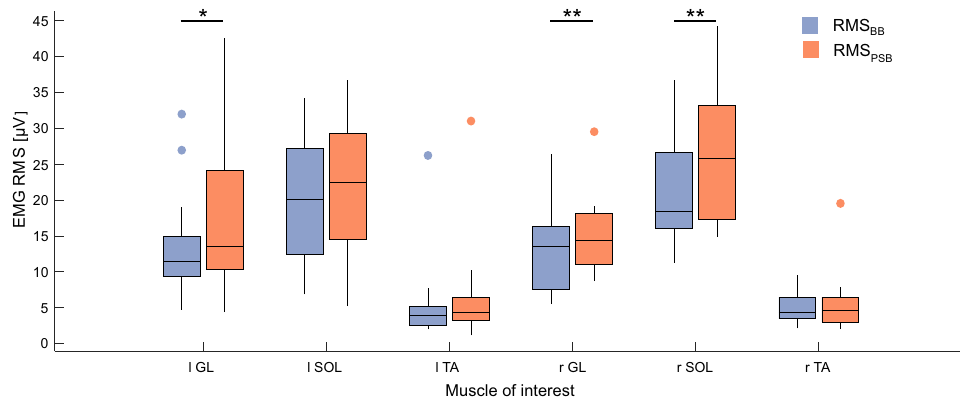
Figure 1:. sEMG RMS before and after the WBVs. RMS values of lower limb muscles and their difference between the 45 s-long baseline (BB) and post-stimulation (PSB) trials: (*) and (**) indicate p < 0.05 and p < 0.01,